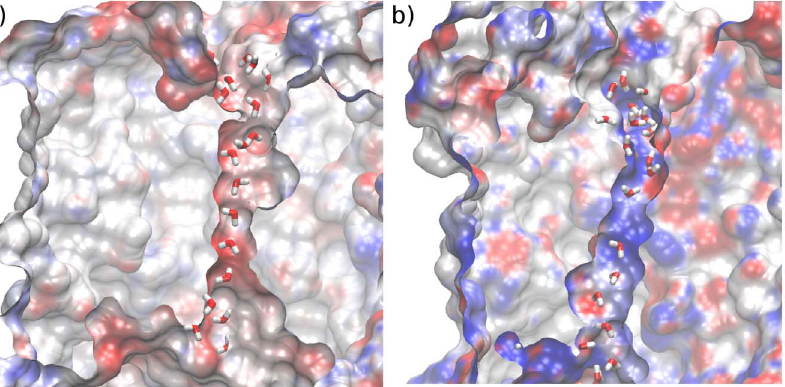
Figure 8. Electrostatic potential on the surface of UT-B (a) and AQP1 (b). View along the pore with water molecules located in the pore. Electrostatic potential defined between 2 10 (red) and 10 (blue) KT/e.